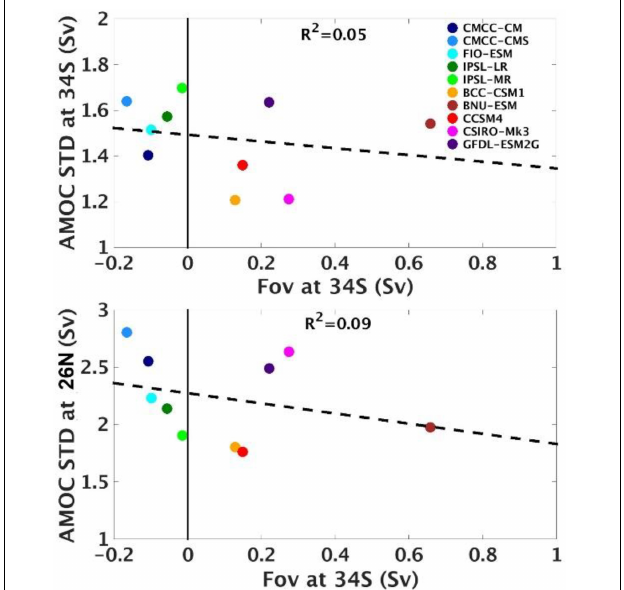
FIGURE 3 | Scatter plot of interannual AMOC variability (Sv) at 34 ◦ S (top) and at 26 ◦ N (bottom) against F ov (Sv) at 34 ◦ S for the 10 CMIP5